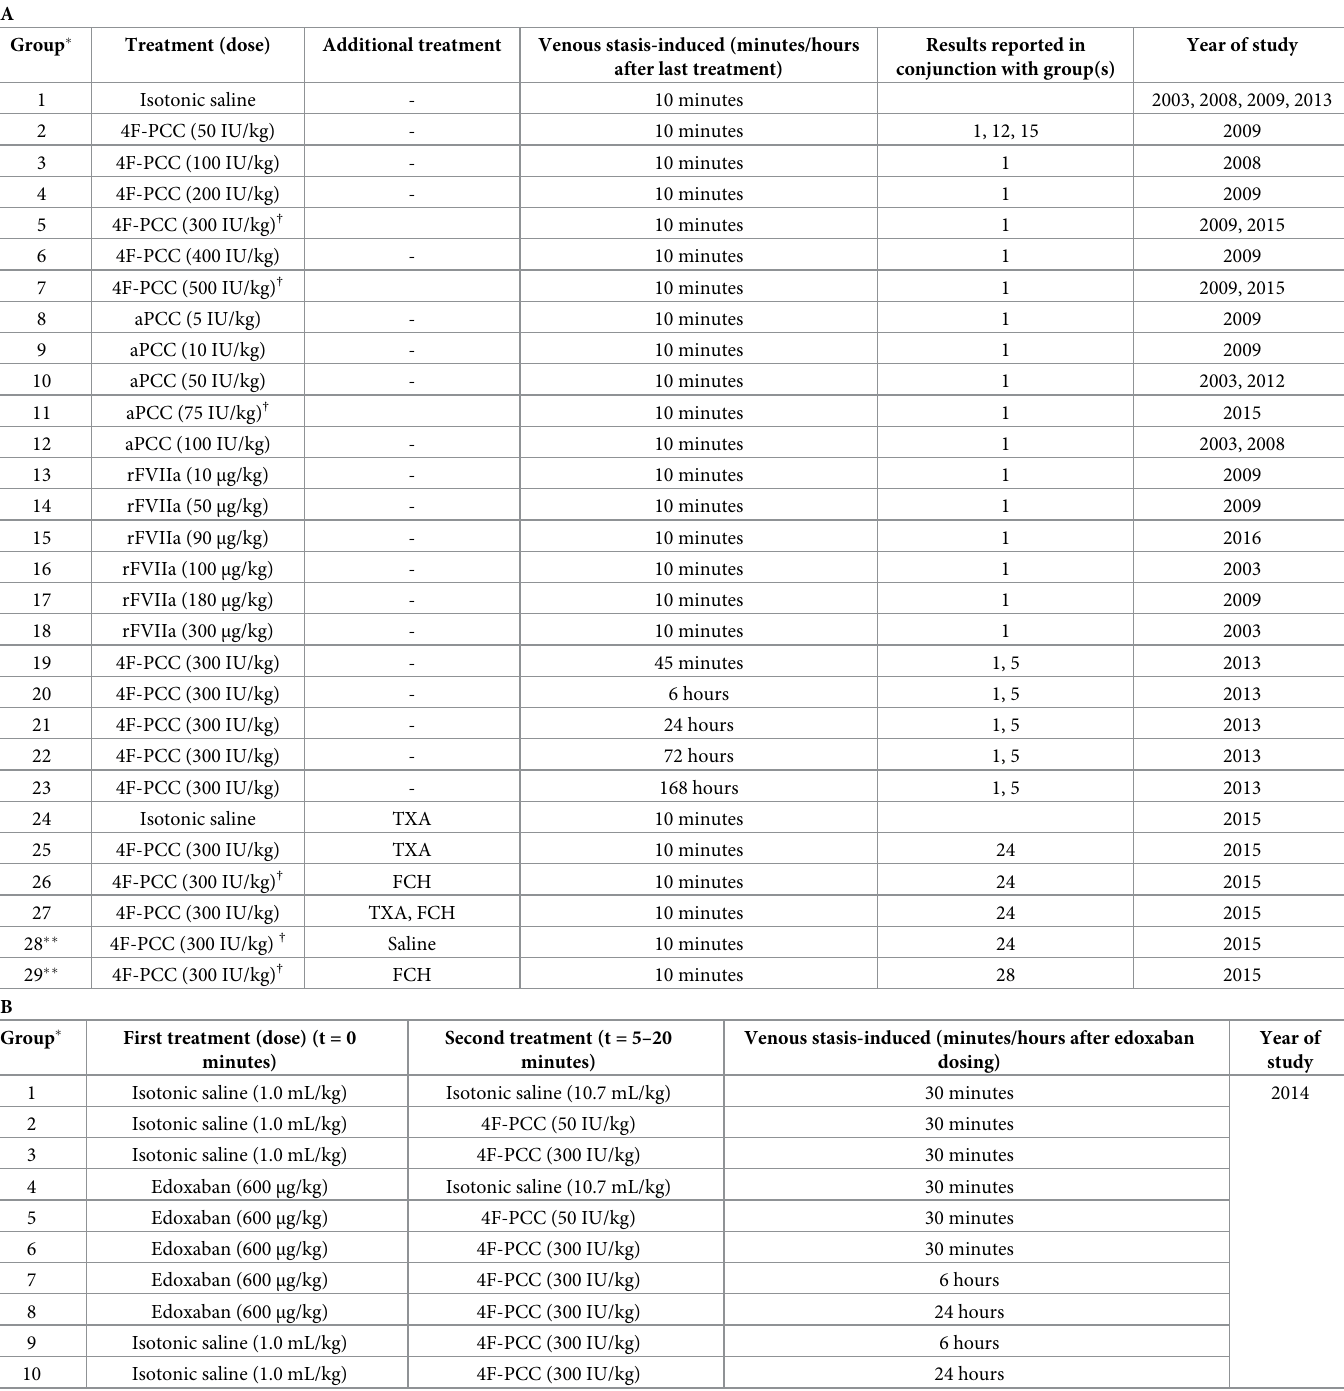
Table 1. Study treatment groups. (A) 4F-PCC in rabbits with dilutional coagulopathy, using modified Wessler model of venous stasis-induced thrombosis; (B) 4F-PCC in rabbits with edoxaban-induced coagulopathy using modified Wessler model of venous stasis-induced thrombosis; (C) 4F-PCC in rats, using a ferric chloride-induced model of arterial